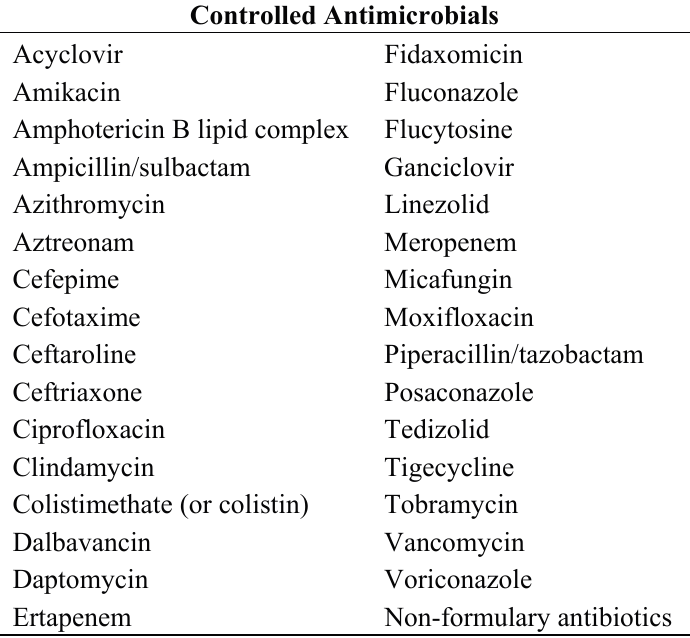
Table 2. Antimicrobials classified as controlled by the antimicrobial stewardship program for community